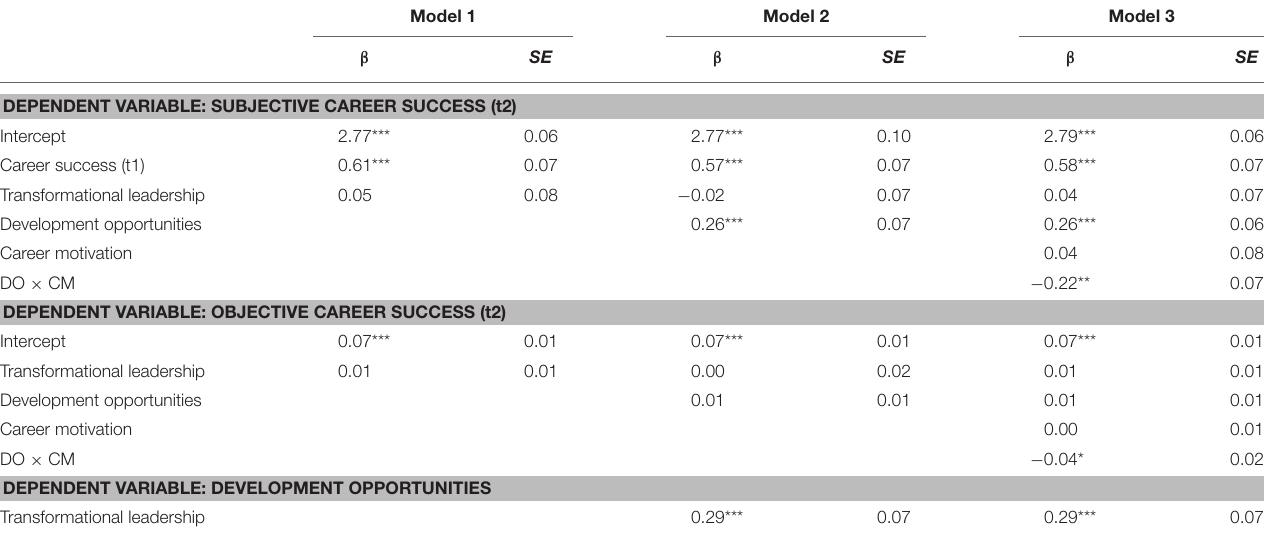
TABLE 3 | Results of the path models of career success ( N =